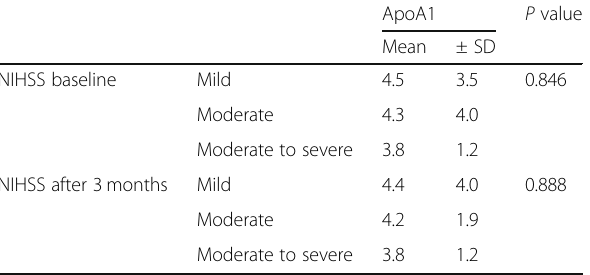
Table 1 Correlations between ApoA1 level and NIHSS at admission and after 3 months